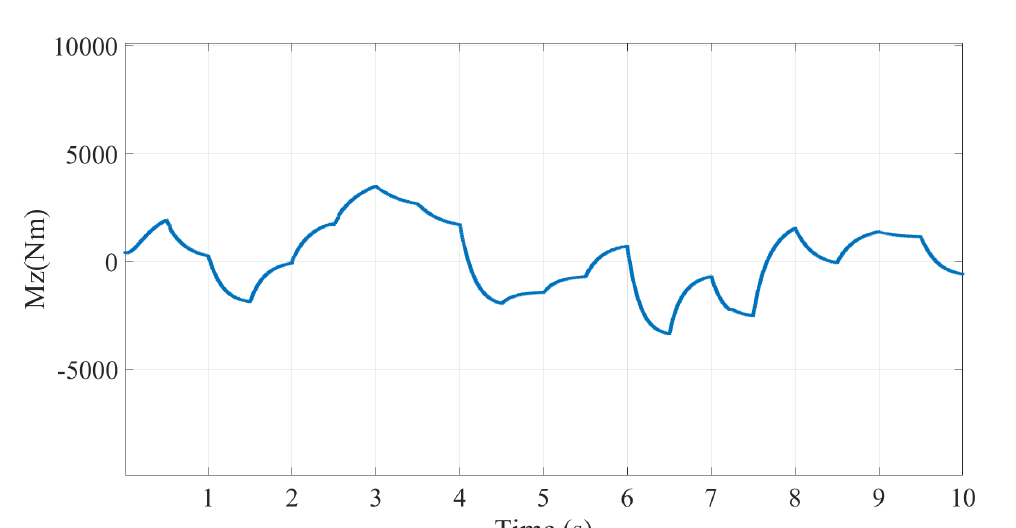
Figure 21. Control output of the